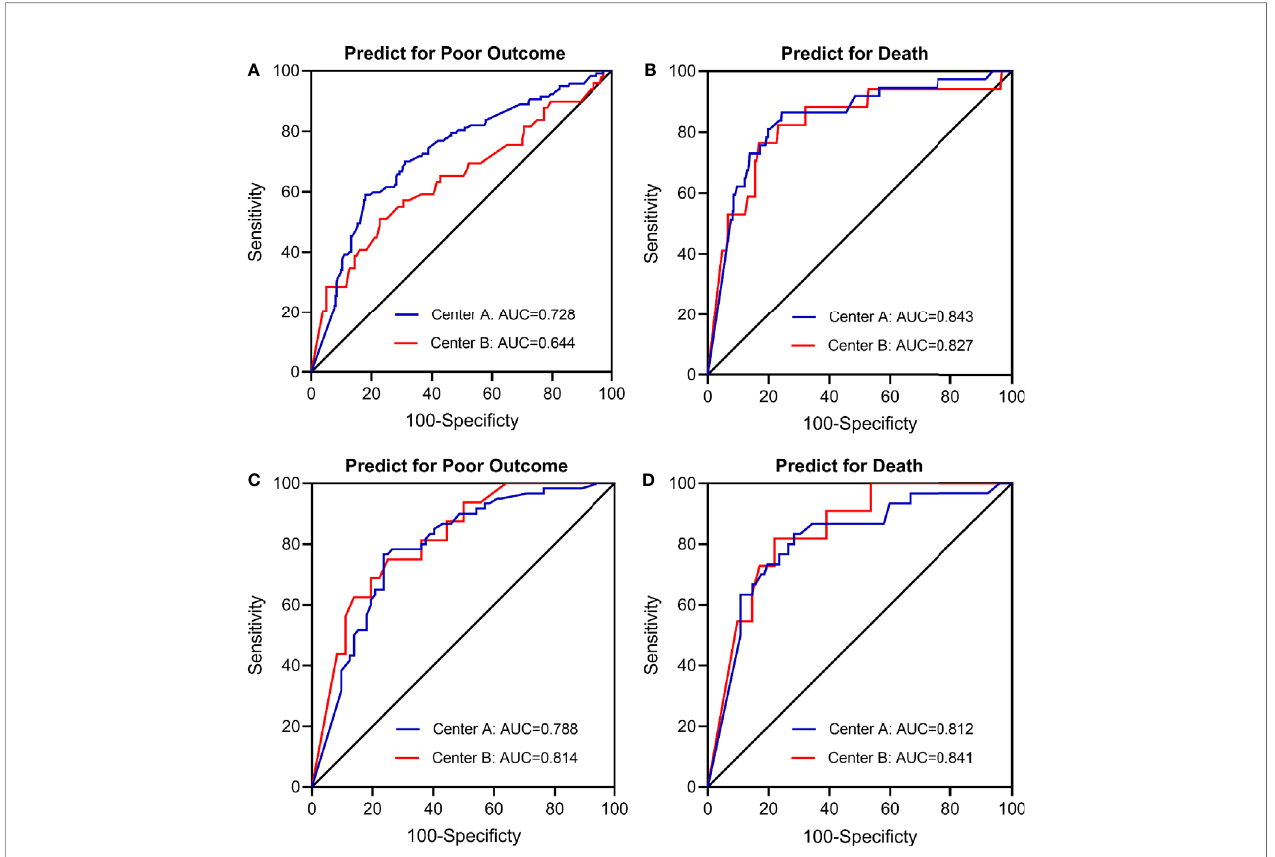
FIGURE 4 | Receiver operating characteristic (ROC) curve for the value of eosinophil changes after intravenous thrombolysis to predict (A) Poor outcome in total patients (n = 623); (B) Death in total patients (n = 623); (C) Poor outcome in cardioembolic stroke only (n = 187); (D) Death in cardioembolic stroke only (n = 187). Center A: The Third Af fi liated Hospital of Wenzhou Medical University; Center B: The First Af fi liated Hospital of Wenzhou Medical